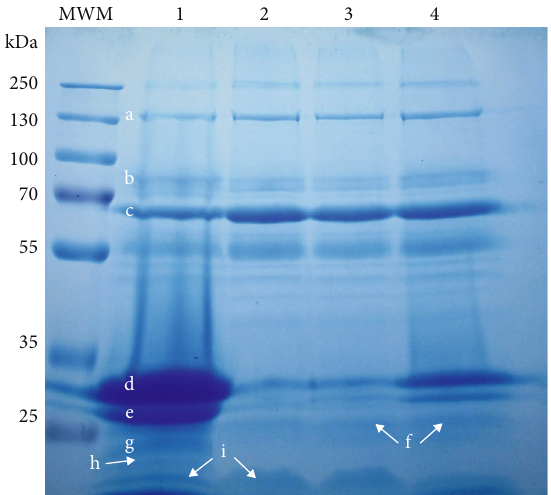
Figure 7: Proteins observed in the whey released by milk gels clotted with Trompillo proteases (lane 1), recombinant camel chymosin (lane 2), bovine chymosin (lane 3), and the mixture (1 :1 ratio) of recombinant camel chymosin with Trompillo proteases (lane 4). MWM=molecular weight marker, a=immunoglobulins, b=lactoferrin, c=serum albumin, d= β - -caseins, f= κ -caseins, g= γ -caseins, h=hydrophilic caseins, e= α s 1 peptides ~ 18kDa, i= β